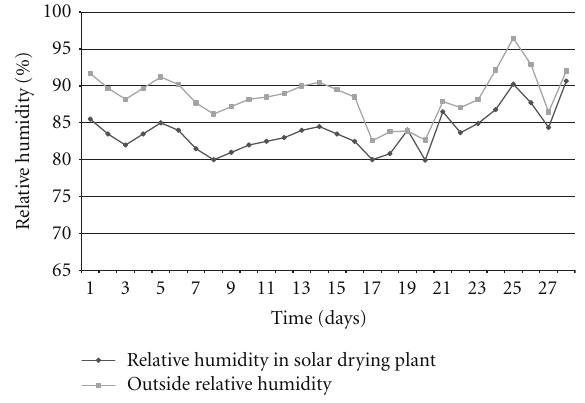
Figure 9: The course of relative humidity during the winter cycle